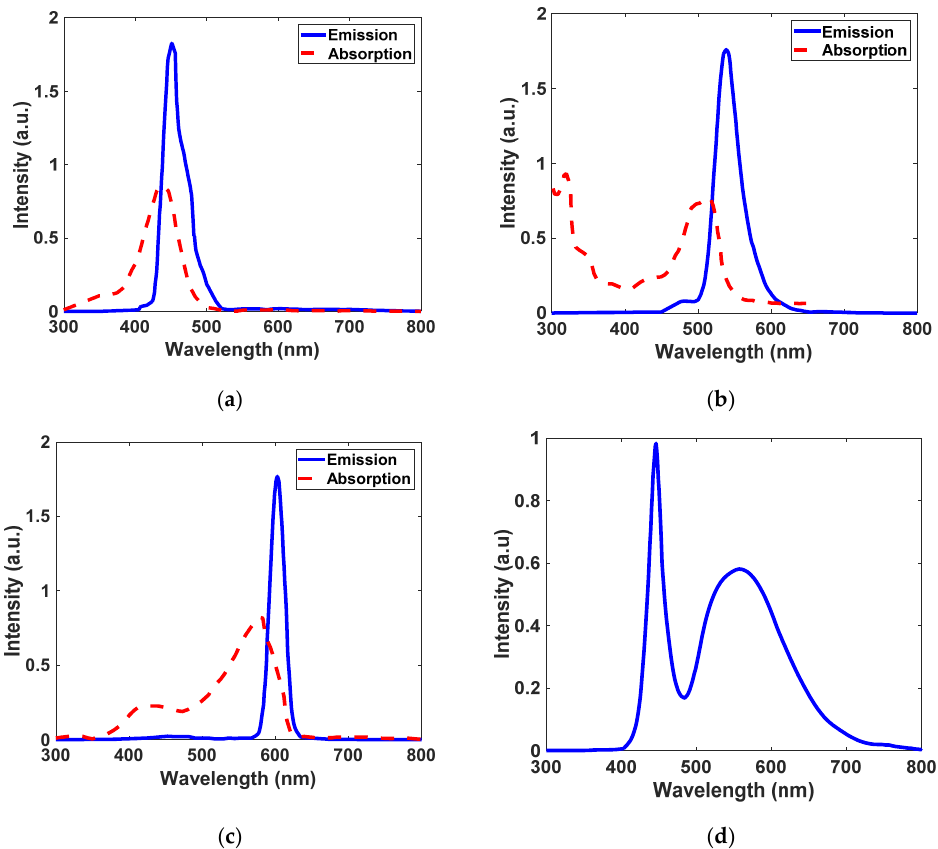
Figure 2. Experimentally obtained absorption and photoluminescence spectra for quantum dots and emission spectrum for commercially available white LED. ( a ) Absorption and emission spectra for quantum dot type A: Se/SiO 2 . ( b ) Absorption and emission spectra for quantum dot type B: CdS/SiO 2 . ( c ) Absorption and emission spectra for quantum dot type C: Au/TiO 2 . ( d ) Emission spectrum for commercial white LED.